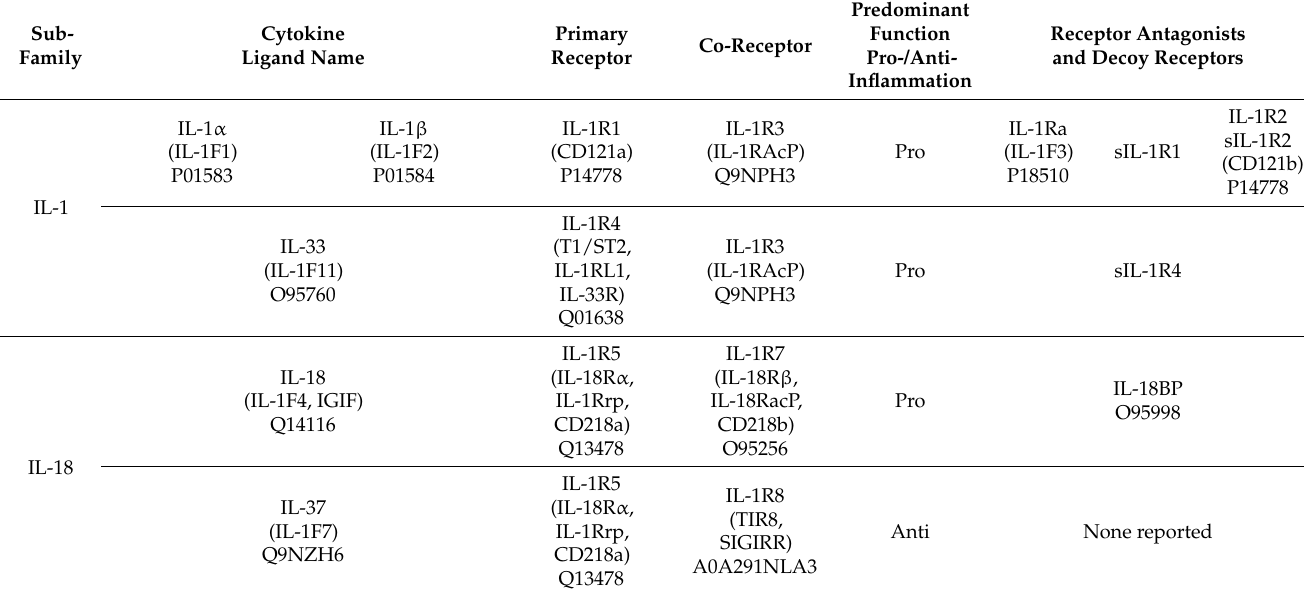
Table 1. IL-1 family ligands and